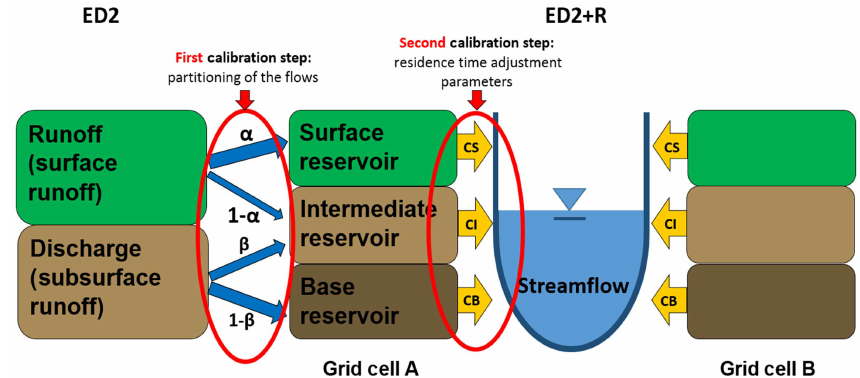
Figure 2. Schematic representation of the connection between the terrestrial biosphere model and the hydrological routing scheme. Cali- brating parameters are circled in red. The reservoirs are used to determine the contribution of streamflow that comes from overland flow, interflow, and groundwater flow. The daily sum of these three reservoirs is then moved from each grid cell into the drainage